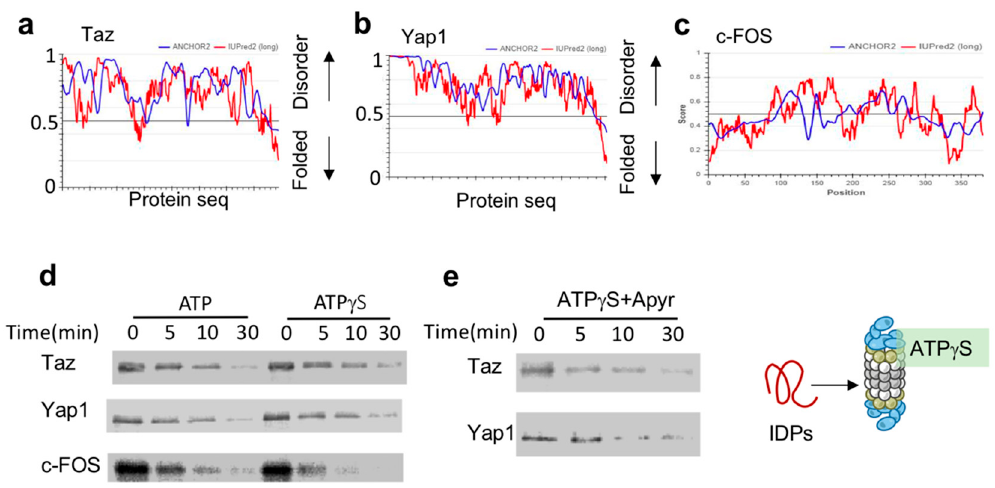
Figure 2. IDPs are degraded by ATP γ S 26S PC (a to c). ( a ) Taz (UniProt Q4V7E6). ( b ) Yap (UniProt P146937) and ( c ) c-Fos (UniProt P01100), are intrinsically disordered based on the scores of prediction output using IUPred2A (the red curve) and ANCHOR2 (the blue curve) prediction programs. ( d ) Taz, Yap1 and c-Fos are degraded by ATP γ S 26S PC. In vitro translated 35 S Methionine labeled and purified Taz, Yap1 and c-Fos were subjected to degradation by the 26S proteasome in the presence or absence of either 2 mM ATP or ATP γ S. ( e ) In the presence of ATP γ S the elimination of residual ATP by preincubation with 5 mu/ μ L apyrase did not inhibit the 26S ability to degrade Taz and Yap1.